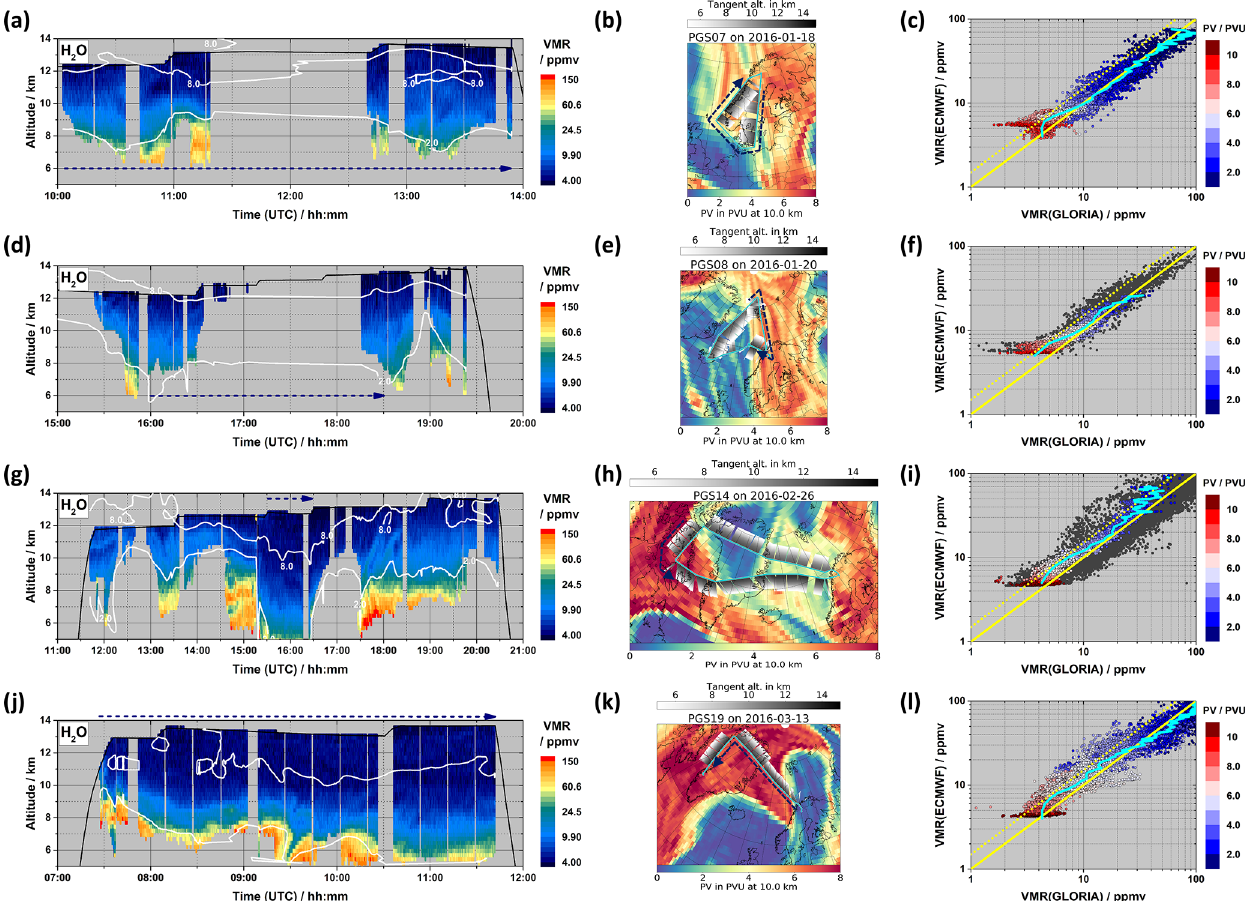
Figure 2. LMS moist bias quantification for selected flights from January to March 2016. GLORIA water vapor (left column), flight path and observation geolocations (middle column), and correlation IFS versus GLORIA (right column) for the flights on 18 January 2016, 20 January 2016, 26 February 2016, and 13 March 2016. For legend see Fig.